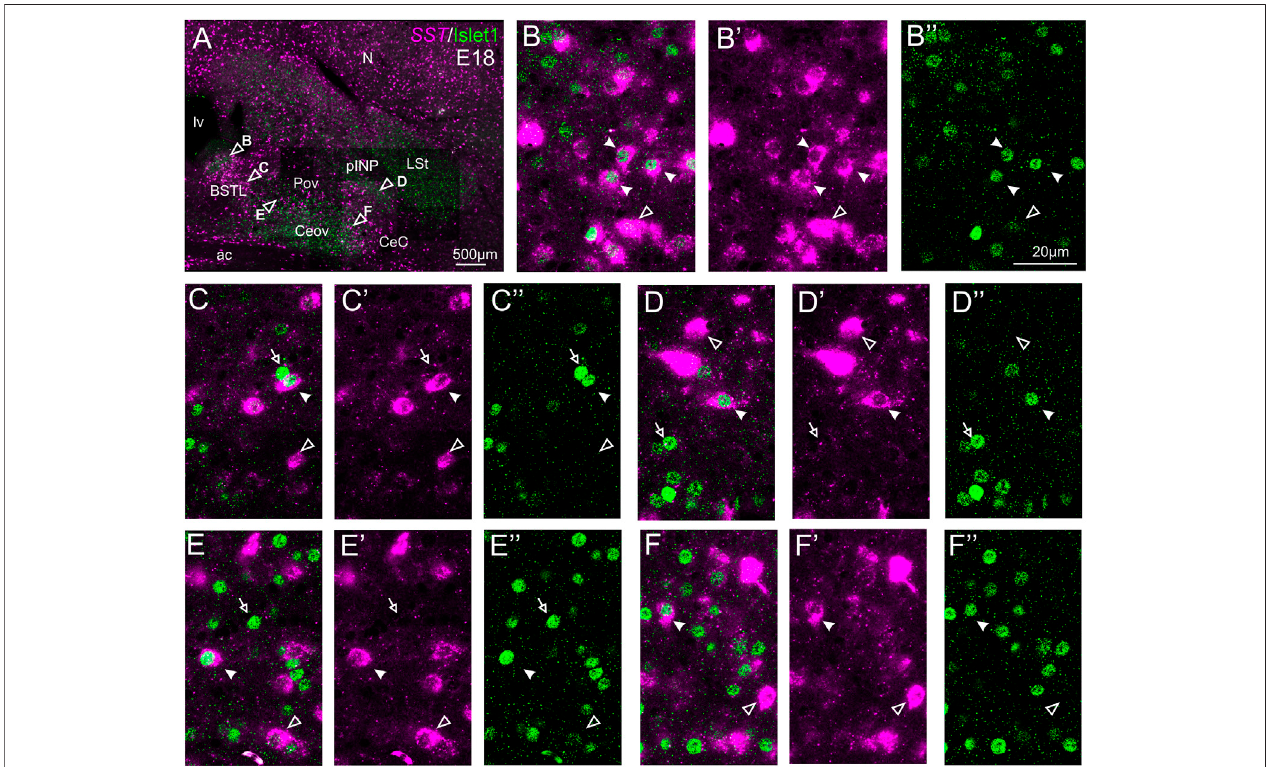
FIGURE8| Double fl uorescence labeling ofsomatostatin( SST ) and Islet1 inthe chicken central extended amygdala at E18. (A) Generalview (×10 objective) ofthe subpallium in a frontal section at the level of the anterior commissure, processed for indirect fl uorescent in situ hybridization for SST (magenta) and immuno fl uorescence for Islet1 (green). Details (×40 objective, only one single z level of the confocal stack) of the areas pointed with arrowheads in A are shown in (B – B 99 ) (for medial BSTL), (C – C 99 ) (for lateral BSTL), (D – D 99 ) (for lateral pINP), (E – E 99 ) (for medial Pov), and (F – F 99 ) (for lateral Pov) (merged plus separate magenta and green channels are shown).Inthesedetails,cellscoexpressing SST andIslet1arepointedwitha fi lledarrowhead,cellssinglelabeledfor SST arepointedwithanemptyarrowhead,andcells single labeled for Islet1 are pointed with an empty arrowhead (only a few examples are pointed). See text for more details. For abbreviations see list. Scale bars: (A) = 500 μ m; (B 99 ) = 20 μ m [applies to (B – B 99 ) to (F – F 99 )